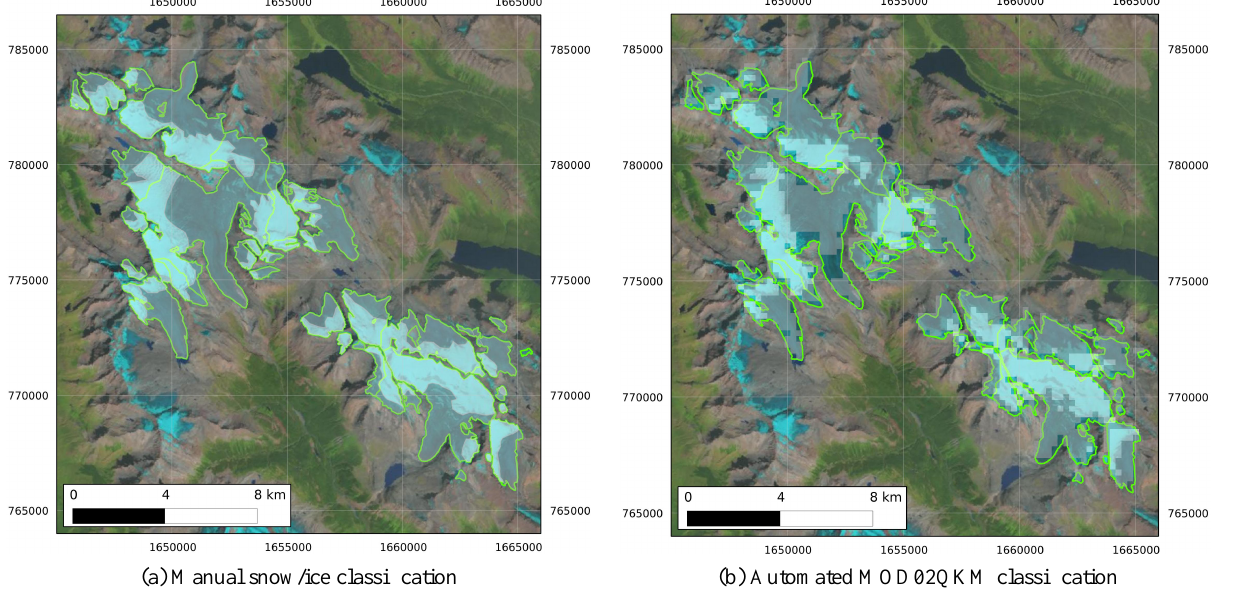
Fig. 7. Landsat 5 scene of the Wapta/Waputik Icefield and Peyto Glacier, 20 August 2009, with (a) manual classification, and (b) MOD02QKM automated classification of snow (white) and ice (grey).